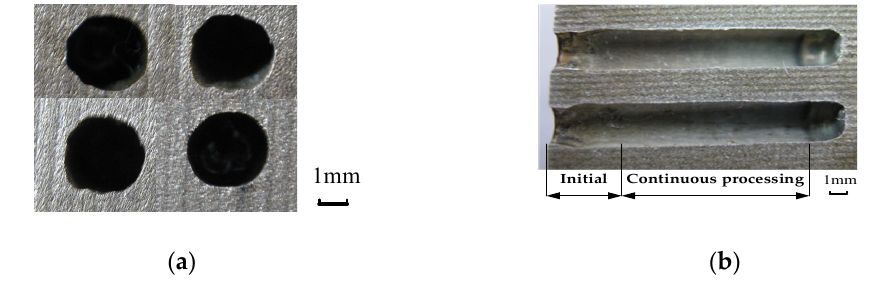
Figure 14. The morphology of the machined holes; ( a ) profile of small holes inlet end; ( b ) profile of keyhole section.